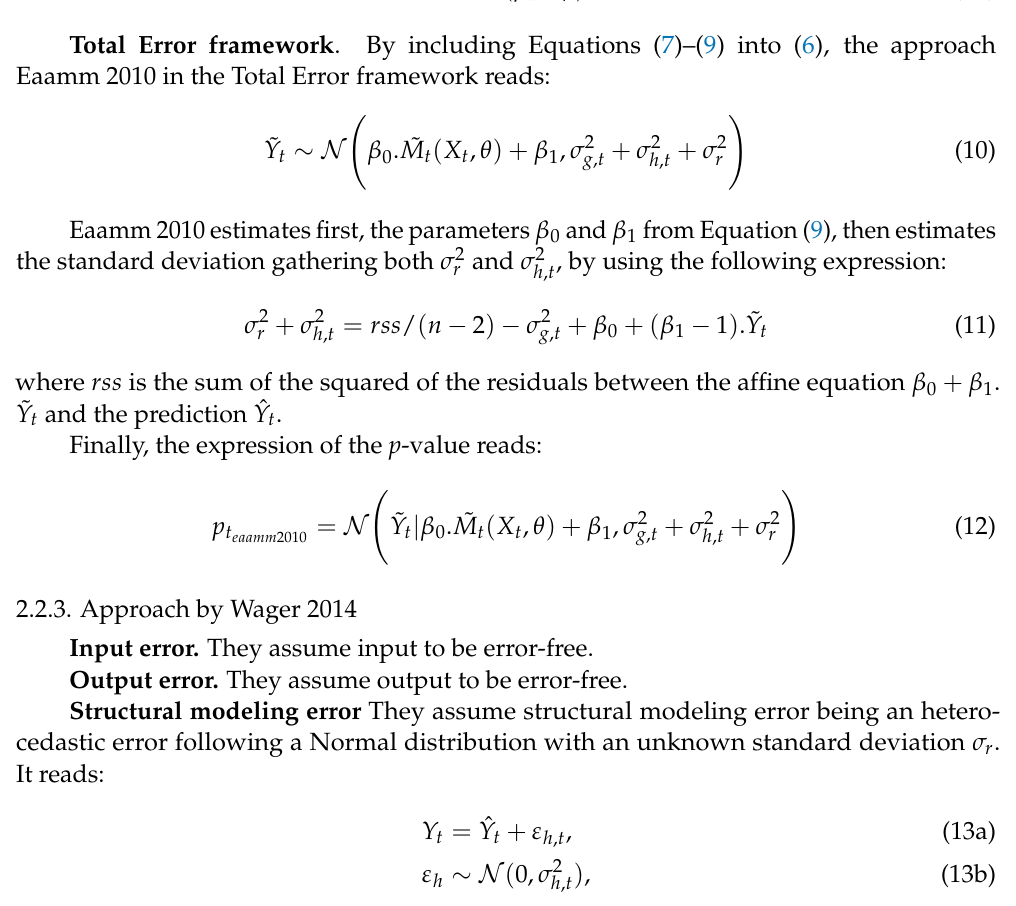
Table 3. Parameters of the measurement error expression. Φ g ,1 and Φ g ,3 are expressed in µ g/m 3 , Φ g ,2 is a percentage. Values from NILU come from an internal technical report. Parameters and Φ g ,2 are divided by 1.96 in order to get a generalization on the whole Normal distribution and not only at the confidence interval 95-percentile (CI95). Parameter Φ g ,3 is a threshold and does not require any division by 1.96. Entity Φ g